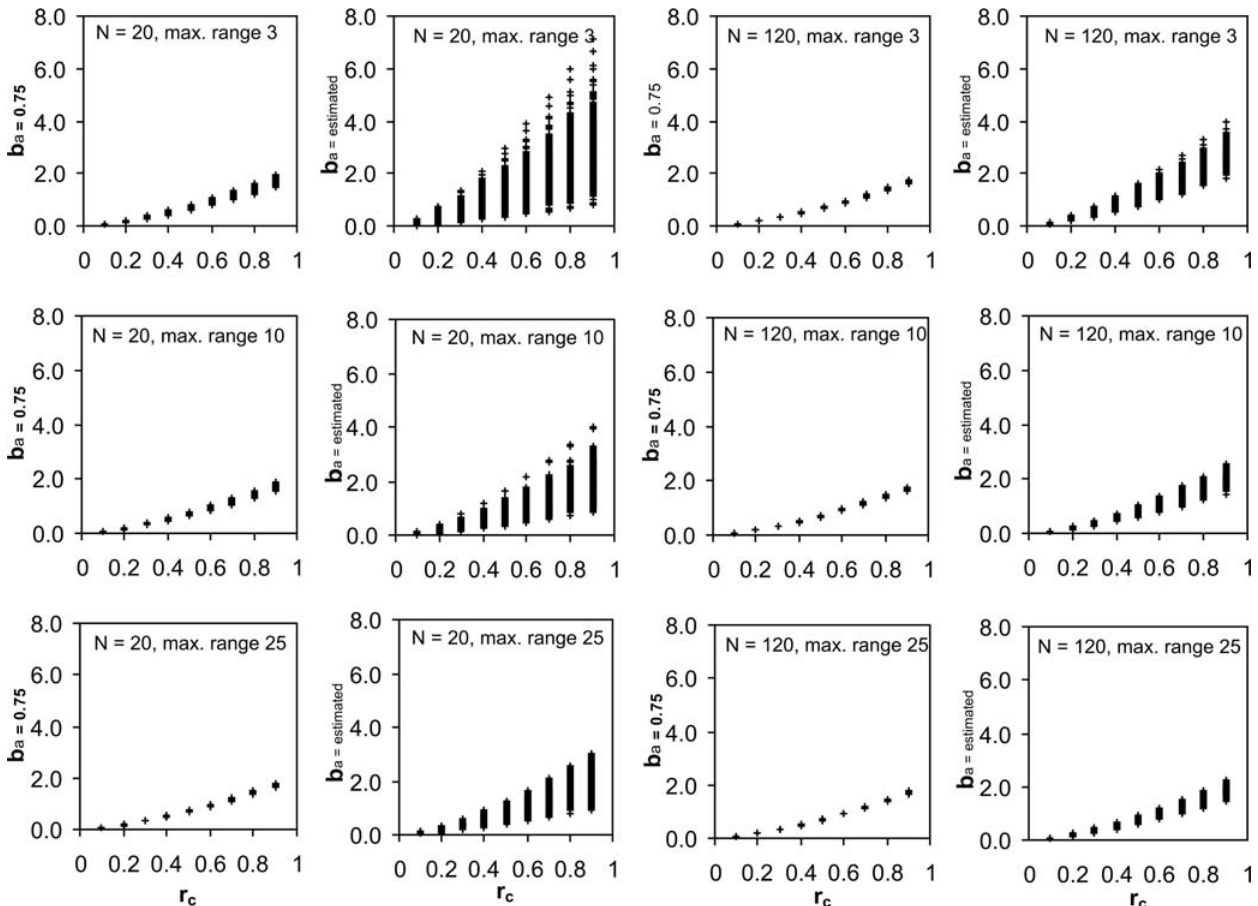
Figure 1. The effect of sample size and data range on the values of the normalization constant. The normalization constant b was estimated by nonlinear regression for sets of allometric data generated with the function Y=2r c1.5 X 0.75 , where 2r c1.5 = b and where random variation was added to both Y and X . Nonlinear regression was then used to estimate the value of b from the data generated either by assuming a constant exponent a =0.75 ( b a=0.75 ) or by allowing the value of a to be estimated by regression (producing b a=estimated ). For each value of r c , the graphs show 600 instances of normalization constants estimated using data with either N=20 or N=120, and with a range approaching 3-fold, 10-fold or 25-fold differences in the values of X . Each instance is shown as a ‘ + ’